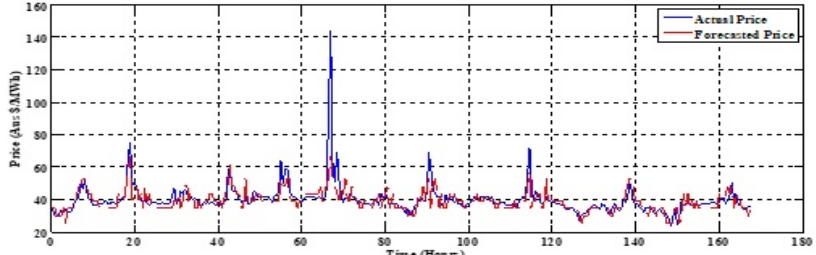
Figure 8. September 8–14, 2015 forecasting while minimum number of features selected in the spring season (MAPE = 8.73).